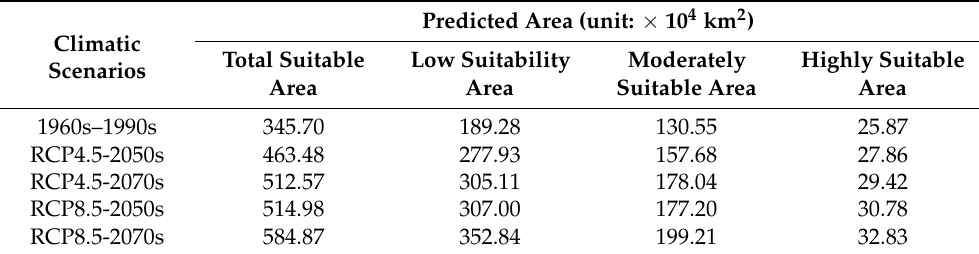
Table 2. The suitable areas of P. tomentosa under different climate change scenarios.